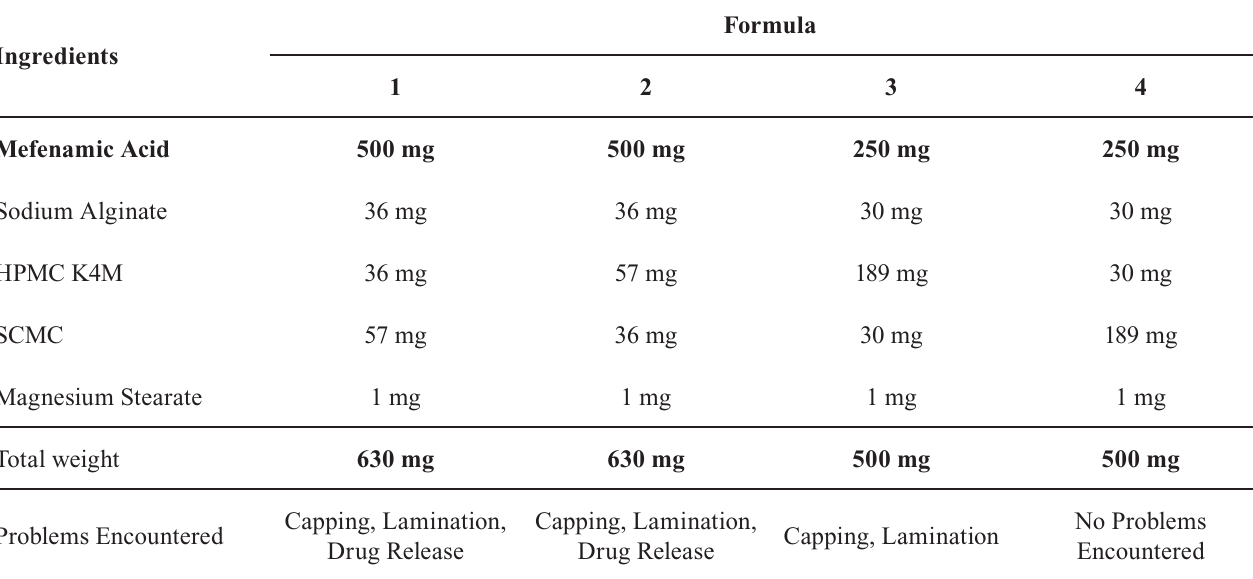
TABLE I - P roblems encountered in the formulated mucoadhesive buccal tablet for mefenamic